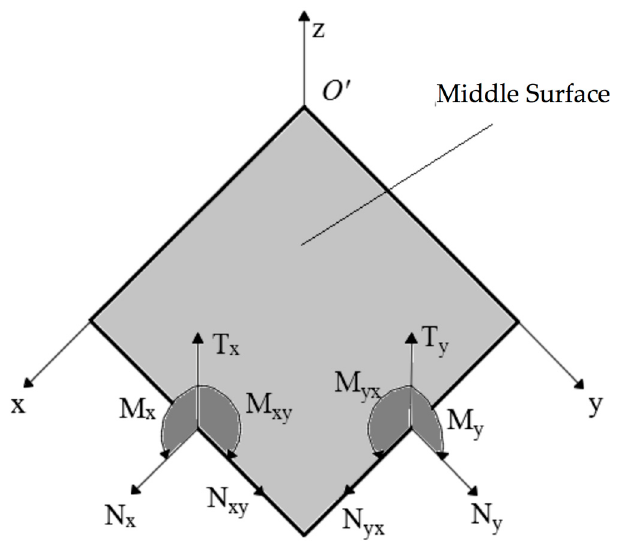
Figure 2. Stress resultants on the middle surface of the plate.